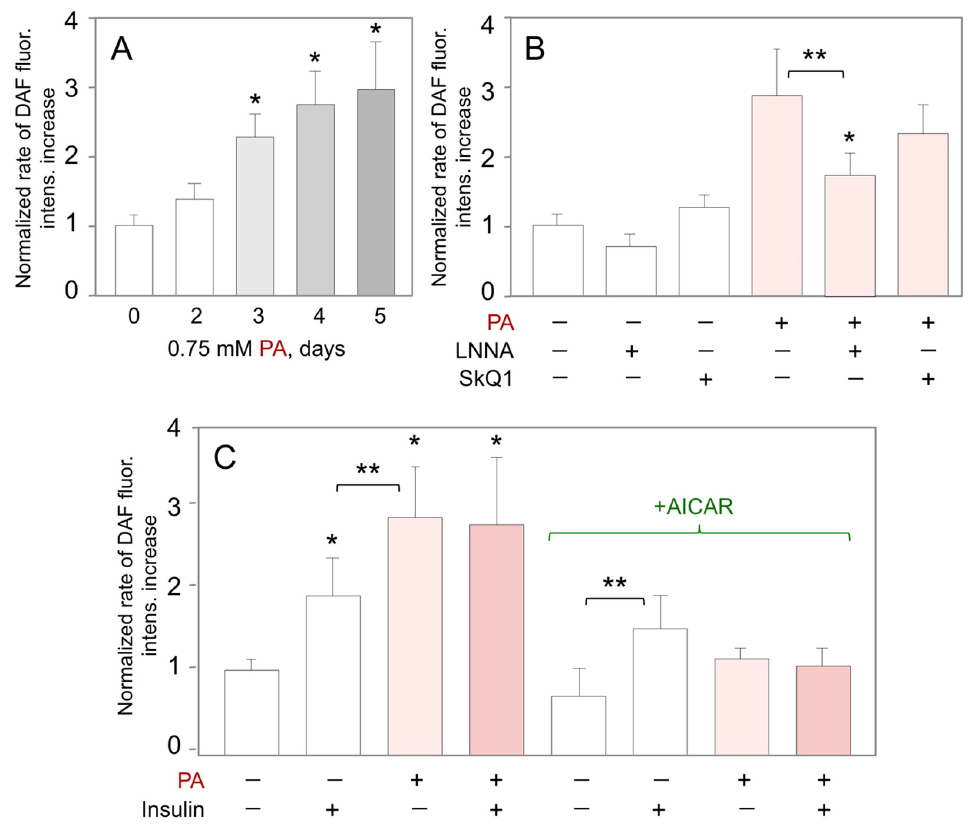
Figure 4. Effects of insulin, palmitate, and AICAR on the rate of NO release by HUVEC. ( A ) Time-dependent changes in the rate of basal NO release in response to 0.75 mM PA (* p < 0.05 vs. day 0, n = 3). Representative raw fluorescent images of DAF-loaded HUVEC at day 0 and day 5 of treatment with 0.75 mM PA are shown in Supplementary Figure S1. ( B ) Inhibitory analysis of the rate of PA-induced NO release measured at day 5 of cell treatment with 0.75 mM PA (* p < 0.05 vs. untreated control; ** p < 0.05 as indicated, n = 3). ( C ) Effects of AICAR (1 mM, 5 days) on the rate of insulin-stimulated NO release in the presence or absence of 0.75 mM PA for 5 days (*, p < 0.05 vs. control cells without AICAR, **, p < 0.05 as indicated by brackets, n = 3).